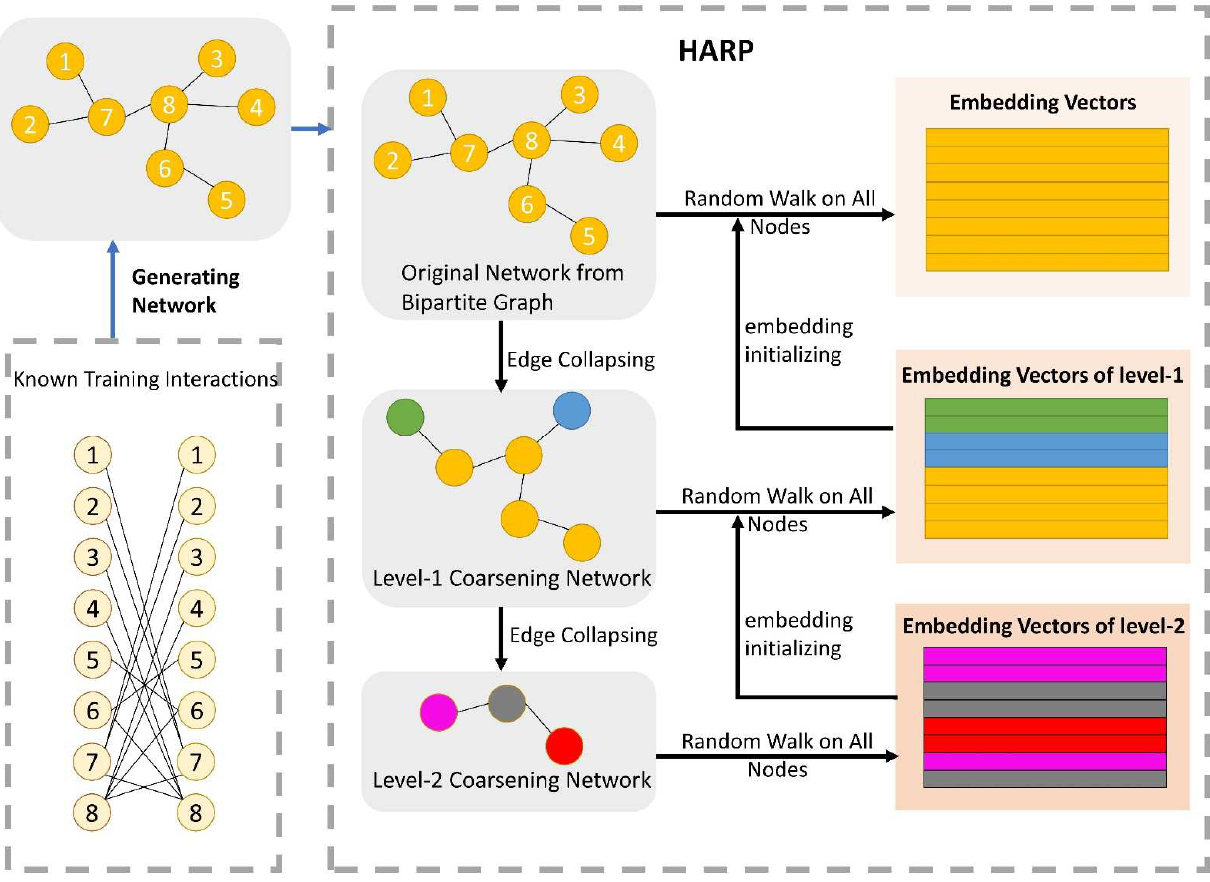
Figure 3. The process of the network representation learning module. There are three parts to HARP: graph coarsening, graph embedding and representation refining. After generating the drug network from the training of the positive samples, the original network is folded continuously to gain many coarse subnetworks. For example, in the level-1 coarsening network, according to the folded rule, node 1 and node 2 are seen as a whole sharing the same embedding vector, when extracting embedding vectors of nodes in the level-1 coarsening network. The final embedding vectors of the lower-level subnetwork are exploited as the initial vector of its superior level subnetwork. Iterating upward constantly, ending at the original graph, and finally obtaining all of the node embedding vectors, which have rich structural information. The LINE method is utilized to obtain embedding vectors for the nodes of each subnetwork.